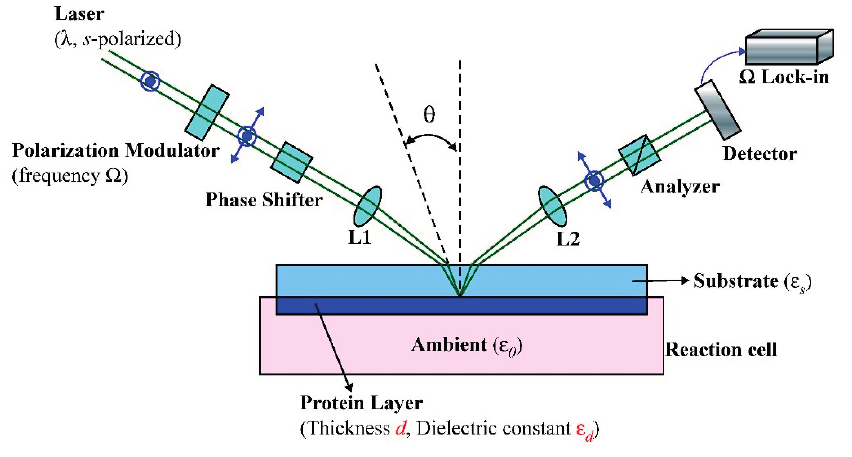
Figure 1. Optical setup of OI-RD. The reaction cell is put above a stirrer. Abbreviations: L1, focal lens; L2, microscope